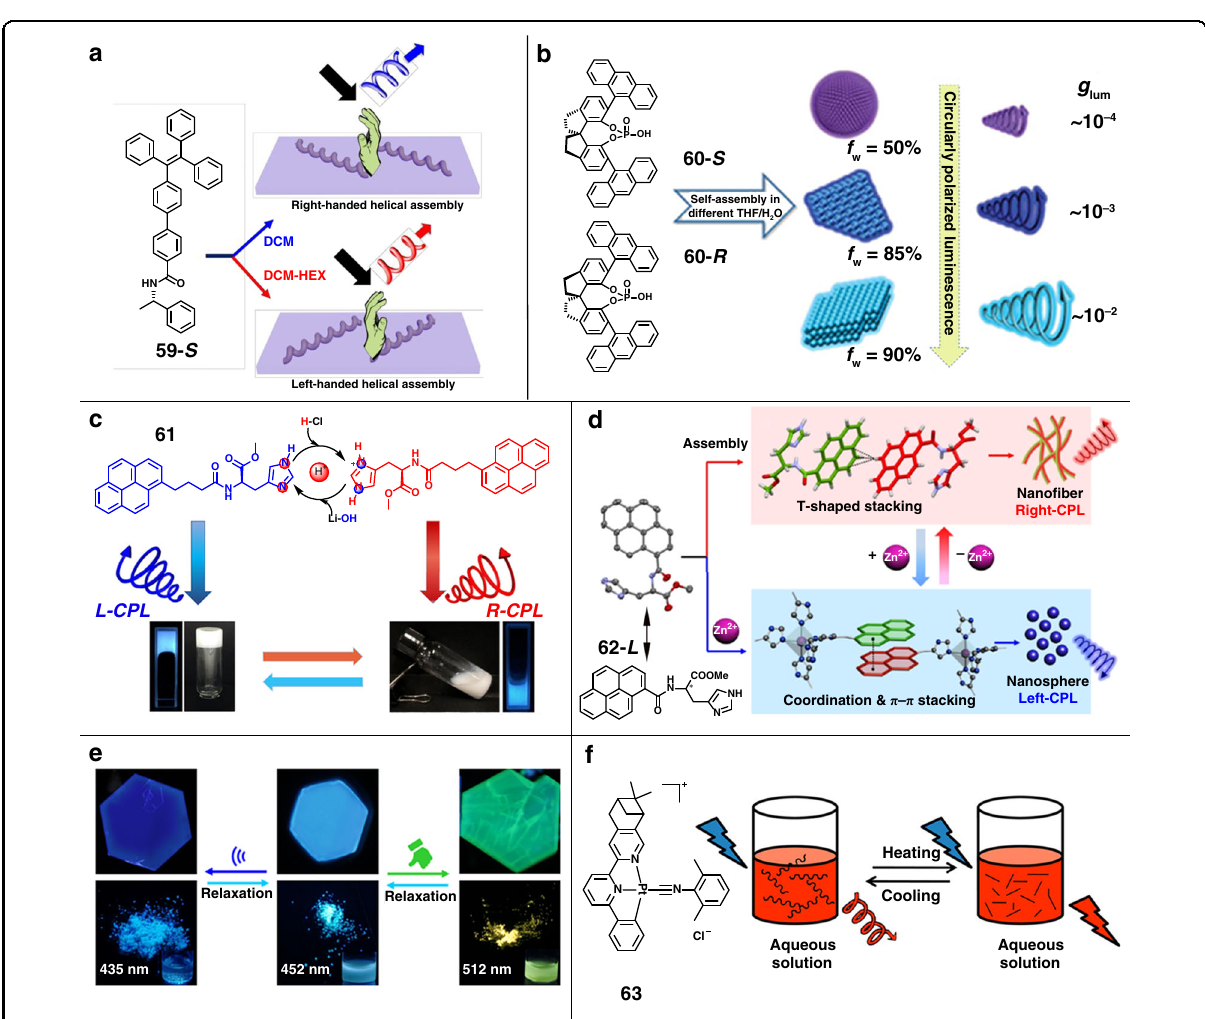
Fig. 7 Schematic illustrations of CPL regulation through different external stimuli. a Solvent polarity. b Solubility. c pH value. d Metal ions. e Mechanical force. f Temperature. Images reprinted with permission from: a ref. 104 , b ref. 35 from RSC; c ref. 105 from ACS; d ref. 107 , e ref. 110 from Wiley, f ref. 111 from